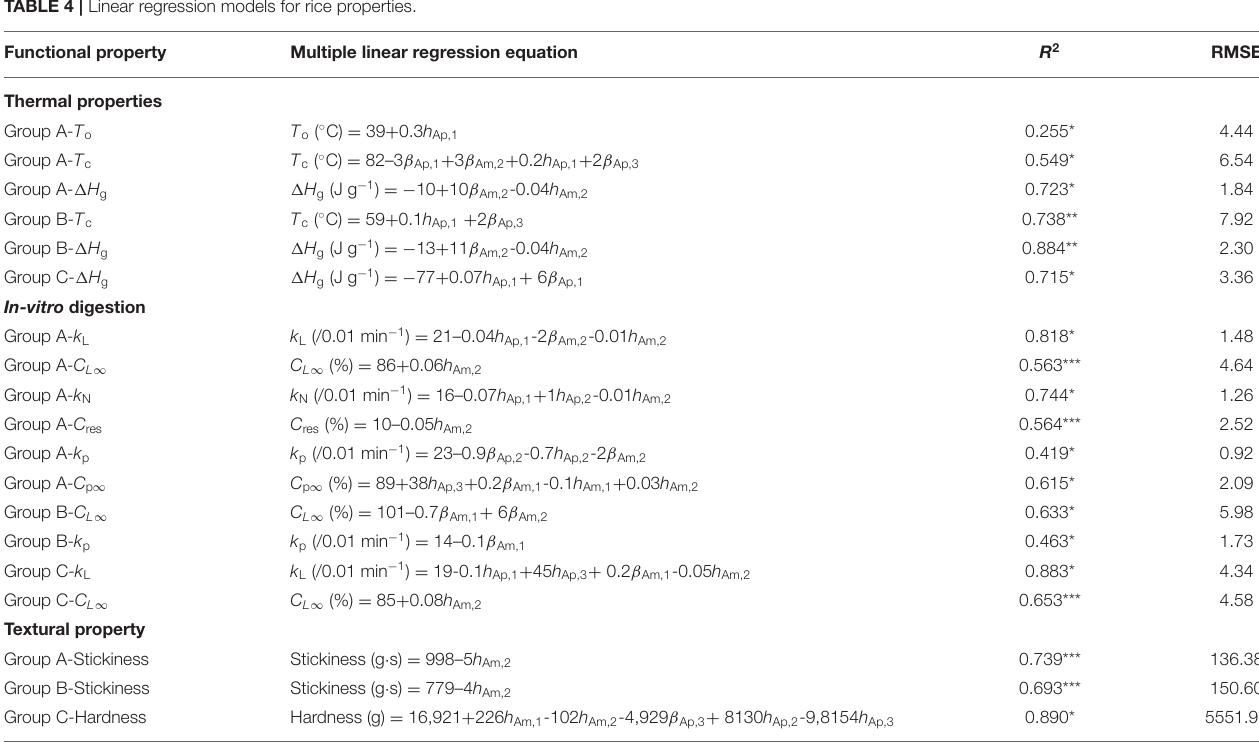
TABLE 4 | Linear regression models for rice